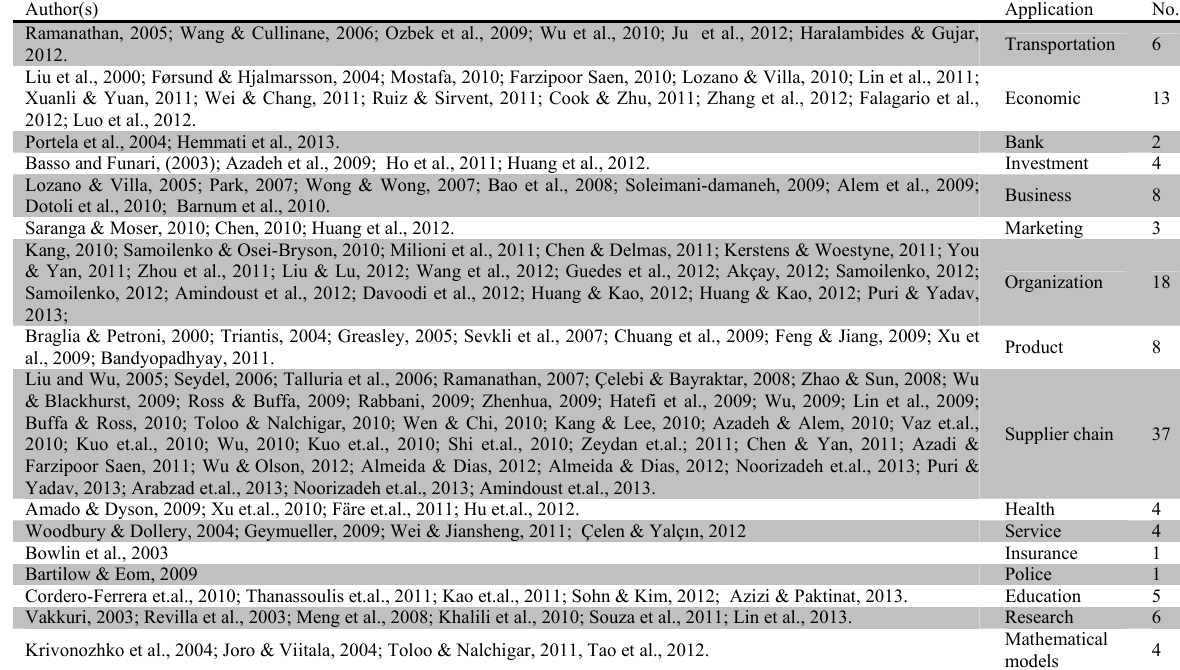
Different issues concerning the application of DEA